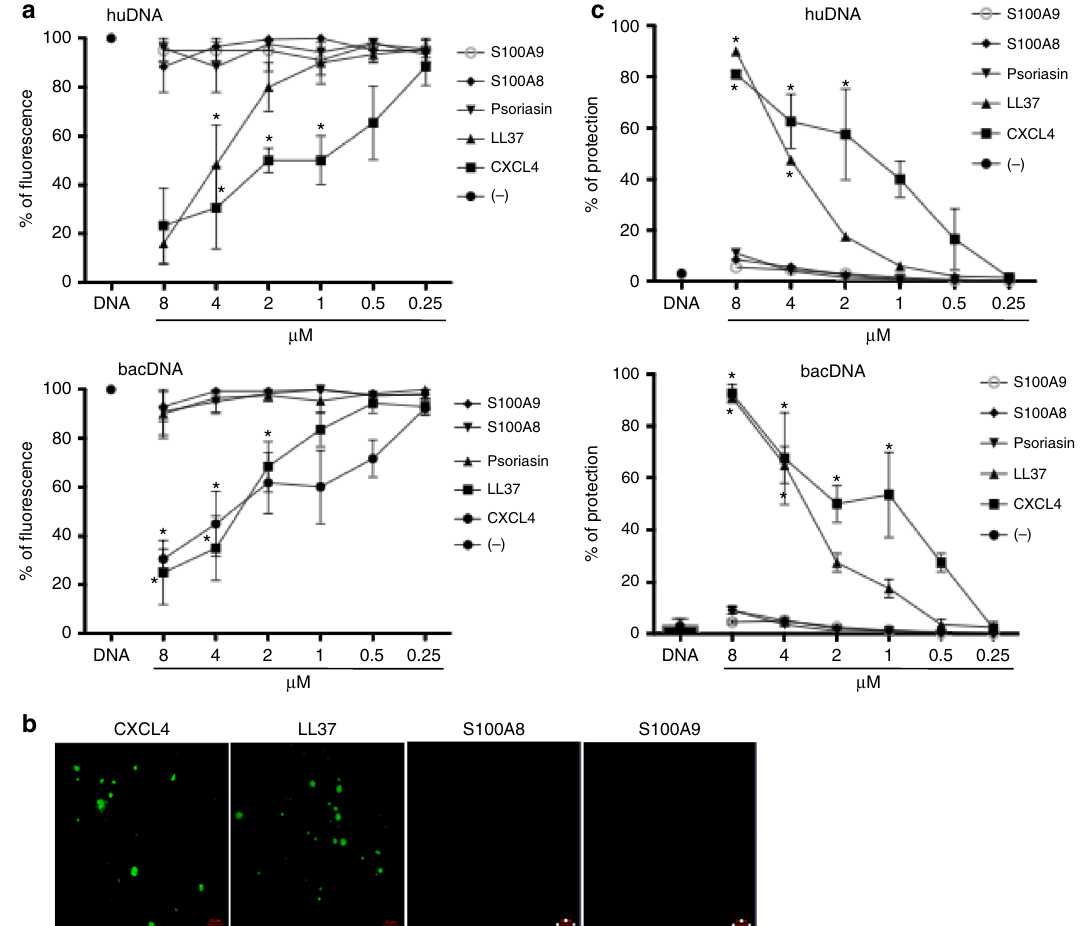
Fig. 2 CXCL4 forms complexes with different DNA types and protects DNA from nucleases. a HuDNA or bacDNA (10 μ g ml − 1 ) were stained with PicoGreen and mixed with different concentrations of the indicated molecules. Fluorescence emission was measured by a fl uorimeter. Data are expressed as percent of fl uorescence with respect to the fl uorescence of DNA alone (100%). Horizontal bars represent the mean, vertical bars are s.e.m. Results from eight independent experiments performed with either huDNA or bacDNA (four each); * P -values < 0.05 by Student ’ s t test for paired samples (two-tailed) are calculated with respect to the fl uorescence of DNA alone; b 10 μ M of the indicated proteins were premixed with 10 μ g of fl uorochrome-conjugated huDNA. Formation of complexes was visualized by confocal microscopy; no binding resulted in a dark panel. One representative experiment out of four. c HuDNA or bacDNA (10 μ g ml − 1 ) were mixed with different doses of the indicated proteins for 20 min in the presence/absence of DNase I (see Methods). Fluorescence was analyzed by PicoGreen assay and percent of DNA protected from degradation calculated with respect to DNA degradation (decrease of picoGreen fl uorescence) obtained in the absence of any molecule (DNA alone). Horizontal bars are the mean, vertical bars are s.e.m. Results from six independent experiments performed with huDNA or bacDNA (three each). * P -values < 0.05 by Student ’ s t test for paired samples (two-tailed) calculated in comparison with degradation of DNA